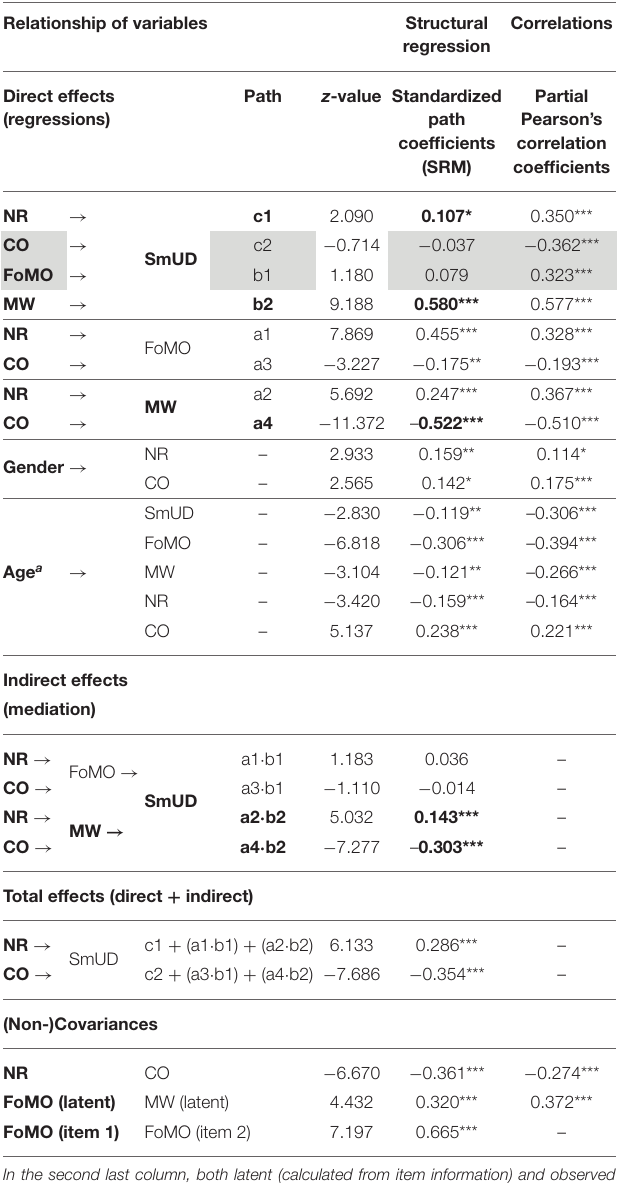
TABLE 3 | Standardized path coefficients of the structural regression model compared to the bivariate correlation coefficients. Relationship of